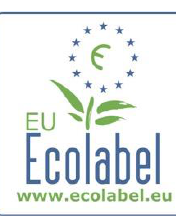
Figure 1. Official EU Ecolabel logo [62]. Figure 1. O ffi cial EU Ecolabel logo